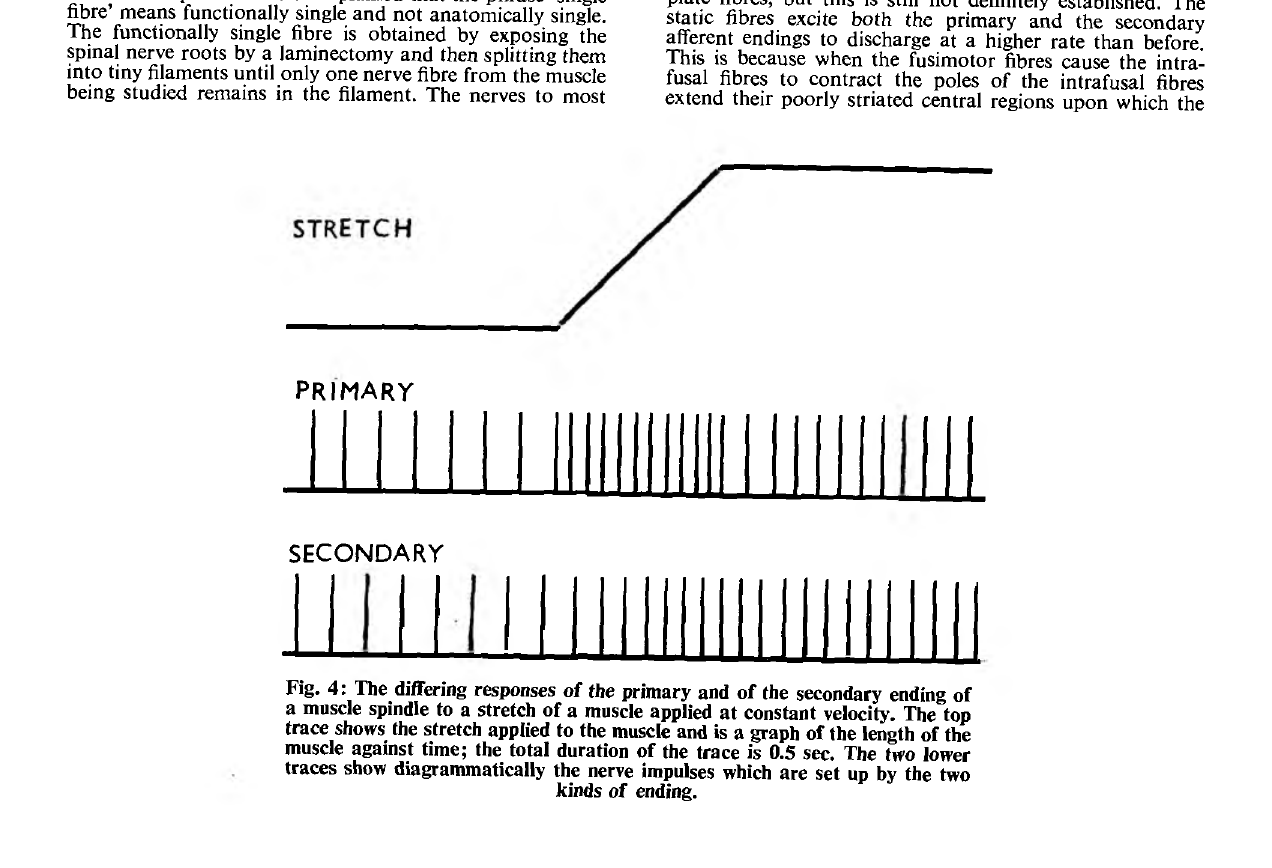
Fig. 4: The differing responses of the primary and of the secondary ending of a muscle spindle to a stretch of a muscle applied at constant velocity. The top t race shows the stretch applied to the muscle and is a graph of the length of the muscle against time; the total duration of the trace is 0.5 sec. The two lower traces show diagrammatically the nerve impulses which are set up by the two kinds of